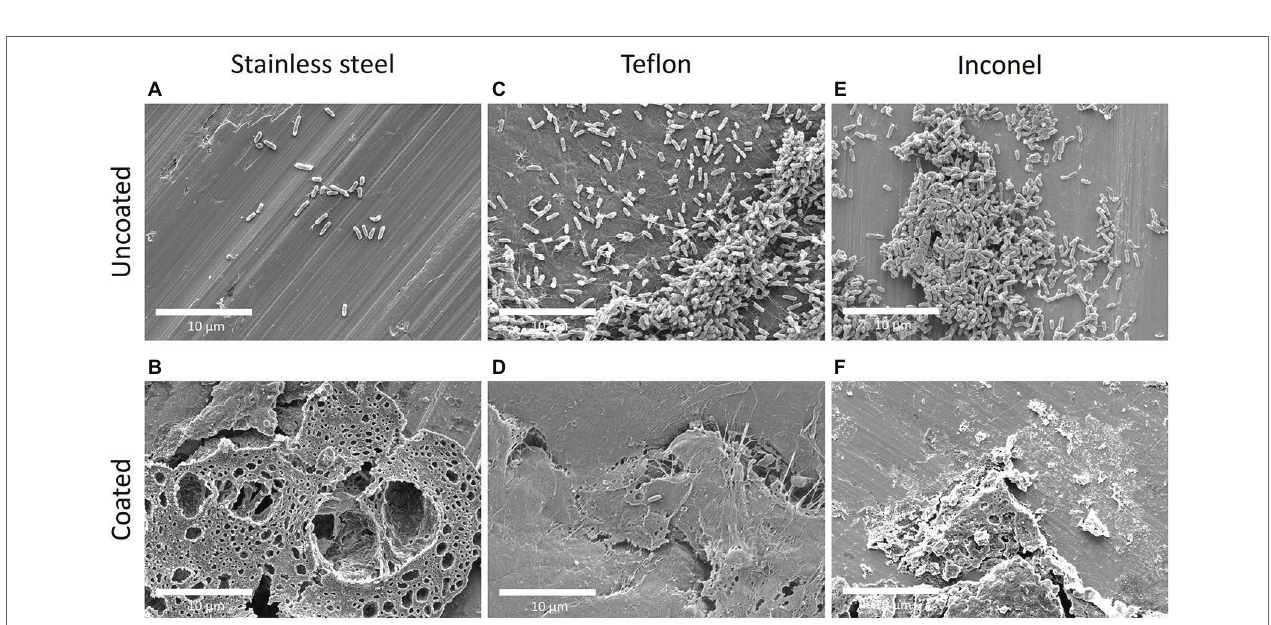
FIGURE 5 | SEM imaging of TSB-grown P. aeruginosa biofilm on stainless steel, Teflon, and Inconel after 48 h. Images (A,B) represent uncoated and coated stainless steel; (C,D) represent uncoated and coated Teflon; and (E,F) represent uncoated and coated Inconel. All biofilms were grown in reactors with TSB as nutrient medium. The coated stainless steel demonstrates the presence of coating and coating